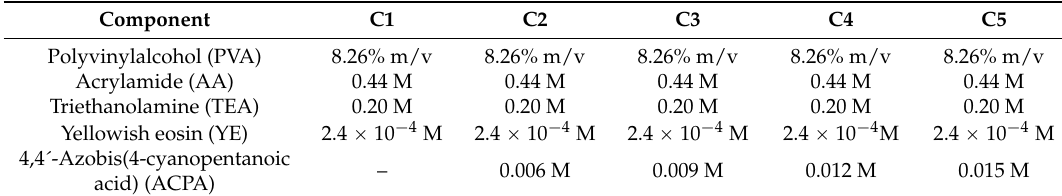
Table 1. Concentrations (C1, C2, C3, C4 and C5) of the photopolymer compositions.